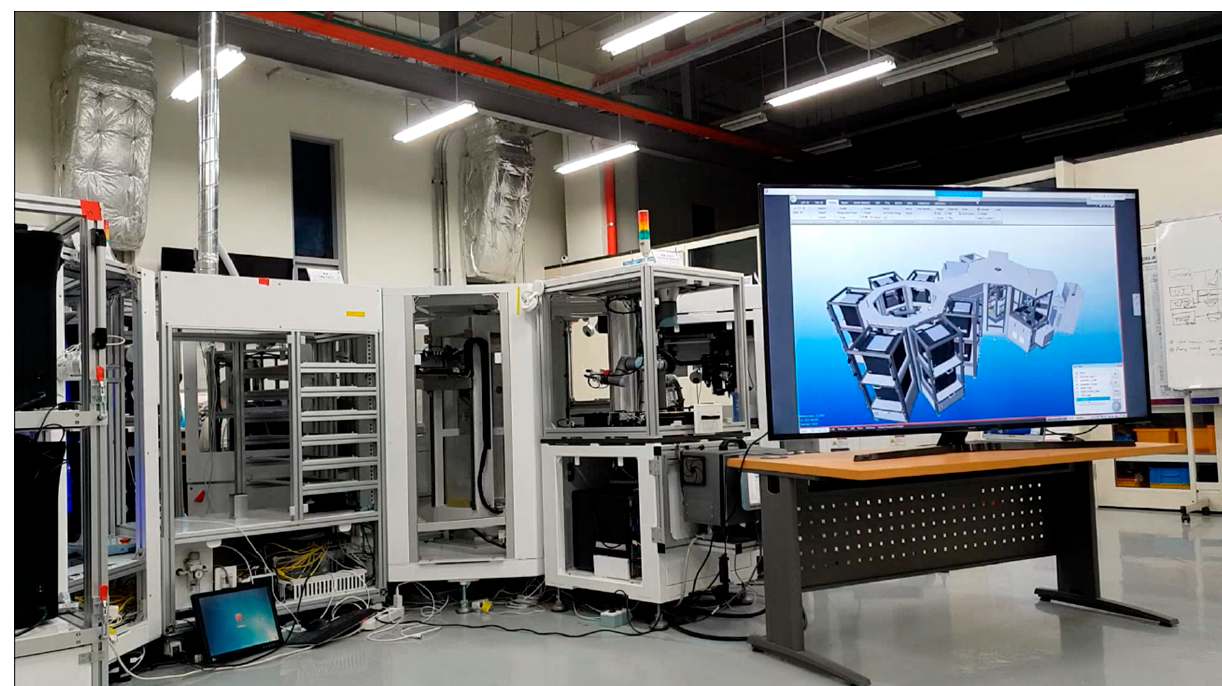
Figure 2. Implemented cyber-physical production system (CPPS) and MSF [7].